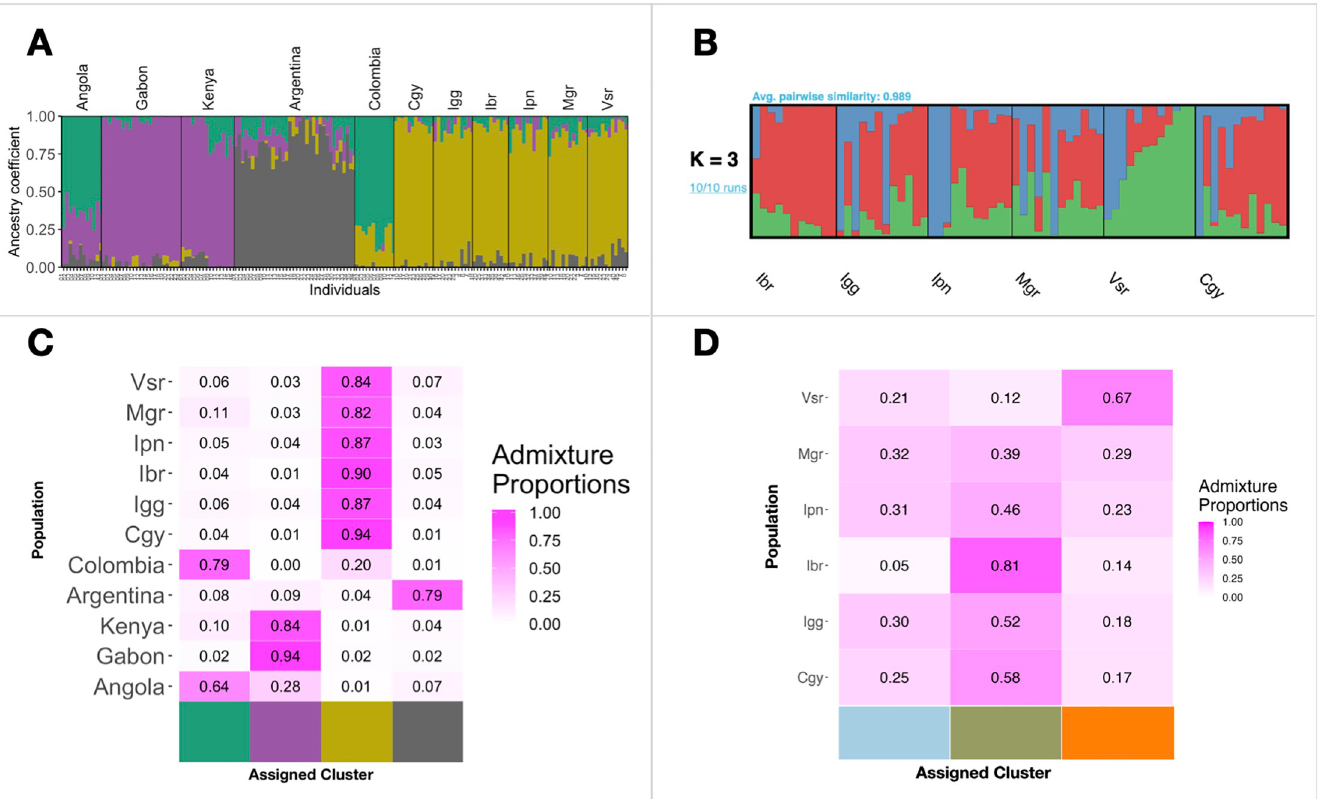
Fig 6. Genetic ancestry of Aedes aegypti populations from Rio de Janeiro. A) with a reference panel of the global populations of Ae . aegypti , estimated using 21,601 SNP loci in LEA with K = 4. Each bar represents one individual. Different colors represent different genetic clusters, and the proportion of a color indicates the probability of an individual assigned to that genetic cluster. We obtained population from other countries described in Kotsakiozi et al. 2018 [90]. Population names and regions are on the x-axis. B) only populations from Rio de Janeiro State with K = 3. C and D. Admixture proportions of each population.